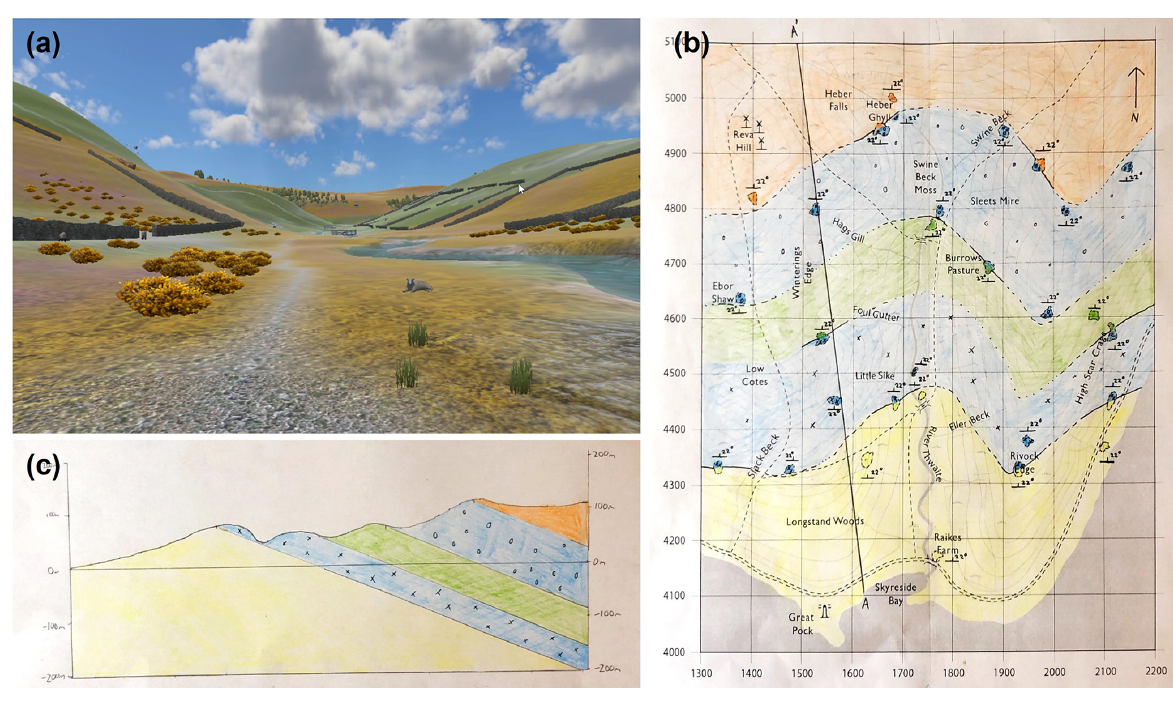
Figure 8. (a) Immersive virtual field mapping exercise, using the Lighthouse Bay Virtual Landscape (Houghton and Robinson, 2017). Example of a student submission of the interpreted (b) geological map and (c) cross section.